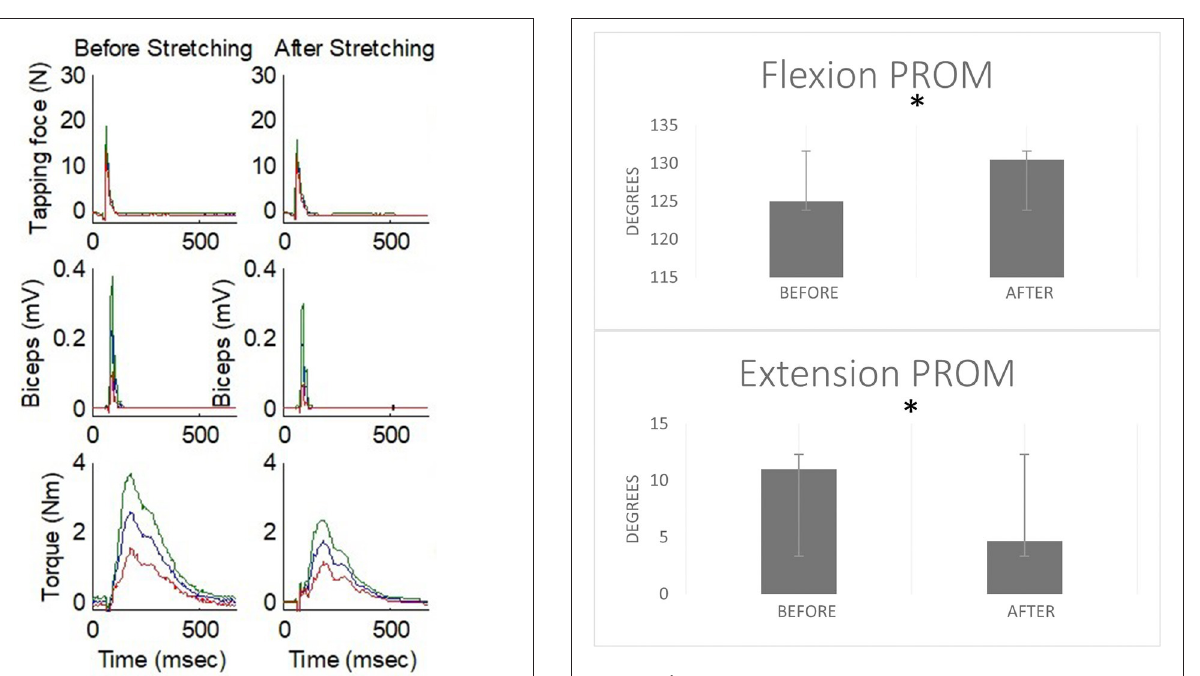
FIGURE 4 | Comparison of before and after stretching for instrumented tendon reflex test results over multiple taps on the biceps tendon of a stroke survivor with spastic elbow. From top to bottom, the three rows show the tendon tapping force, EMG, and elbow flexion torque, respectively. The elbow was fixed at 60 ◦ flexion. The blue line represents the mean value and the red and green lines represent the values 1 SD below and above the mean value, respectively. N, Newton; mV, millivolts; Nm, Newton meters; msec, milliseconds.